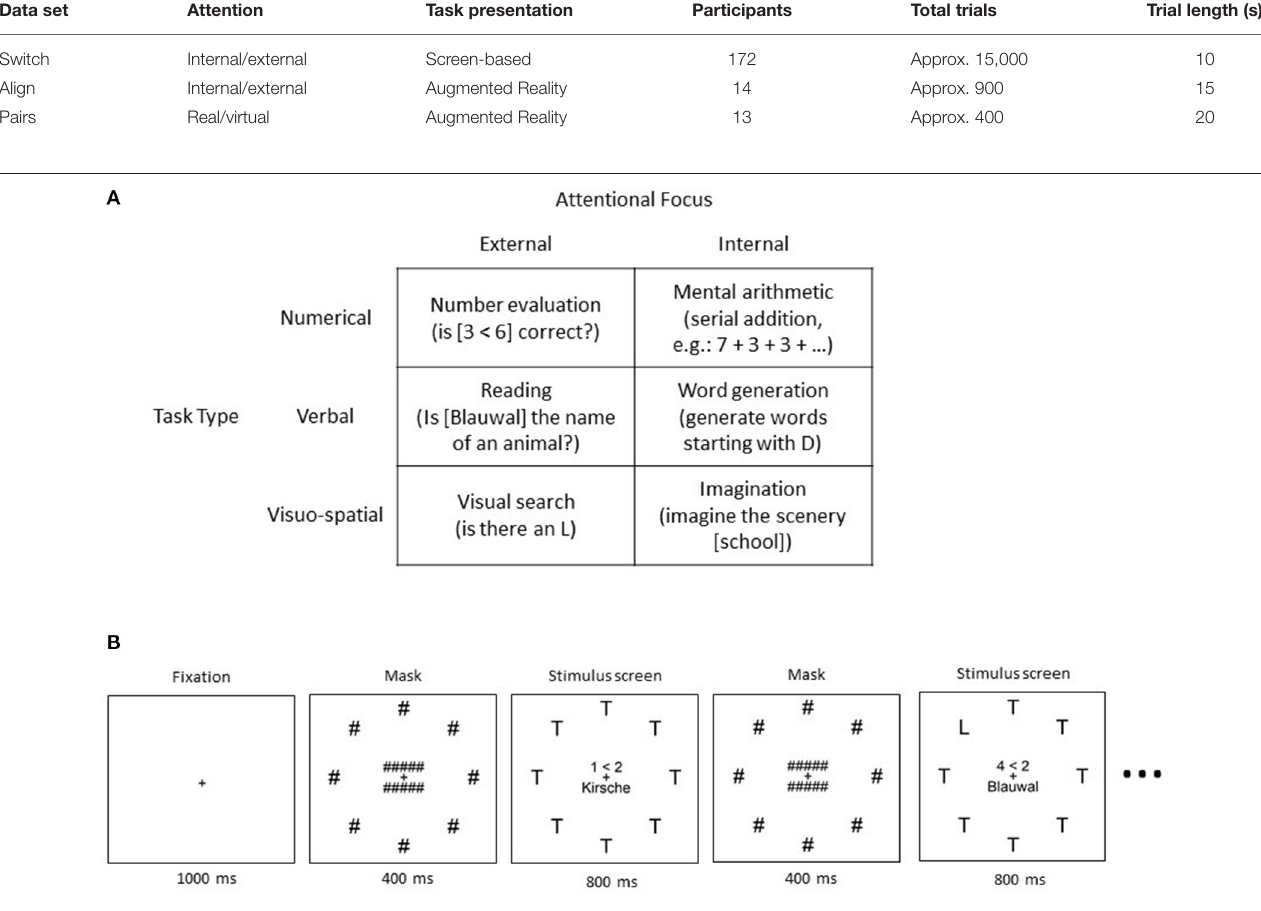
FIGURE 1 | The switch-task: (A) Categorization of the 6 different tasks with examples for each category. (B) Schematic description of the procedure of one trial, including example stimuli and timing information. Taken from Annerer-Walcher et al. (2021).